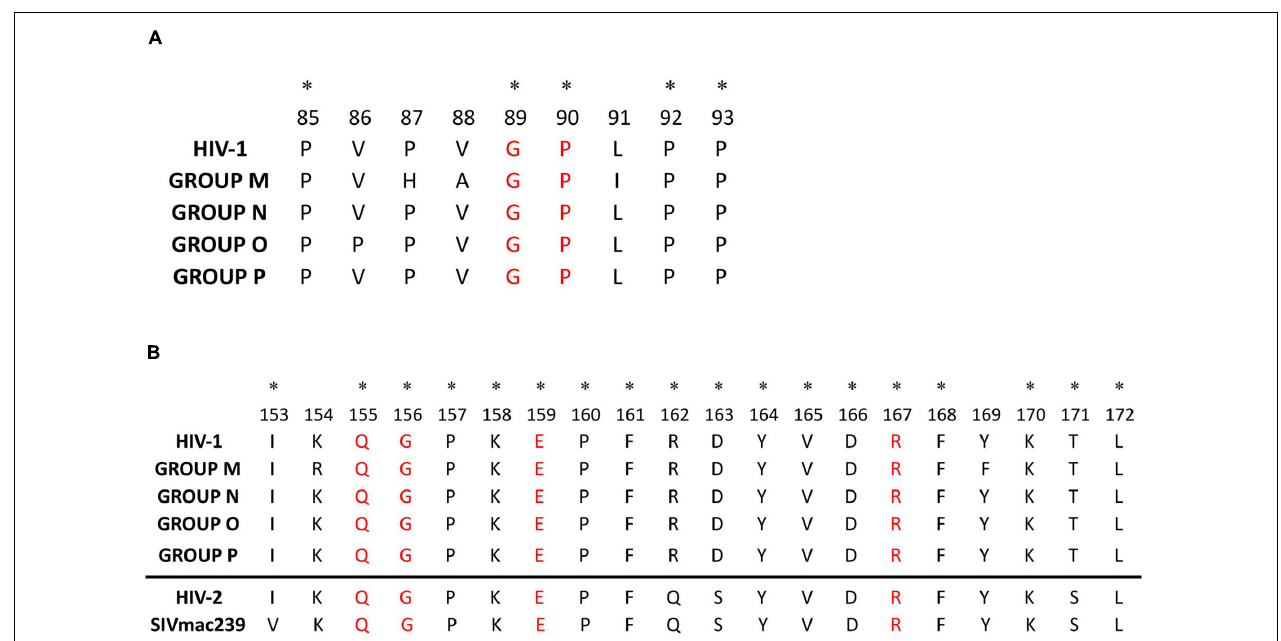
FIGURE 3 | HIV-1 and HIV-1 groups alignment of p24 Cyp A-binding loop (A) and major homology region (B) . (A) Cyp A-binding loop aa alignment (aa 85–93) considering the HIV-1 and the 4 HIV-1 groups consensus sequences. In red, main sites involved in the Cyp A-binding loop interaction; with an asterisk, sites with the same amino acid in all the consensus sequences. (B) Mayor homology region aa alignment (aa 153–172) considering the HIV-1 and the 4 HIV-1 groups consensus sequences. The HIV-2 p26 MHR consensus inferred from LANL sequences and SIVmac239 MHR sequence downloaded from LANL have been added below the line for further information. In red, invariable amino acids in retroviruses MHR; with an asterisk, sites with the same amino acid in all the consensus sequences.